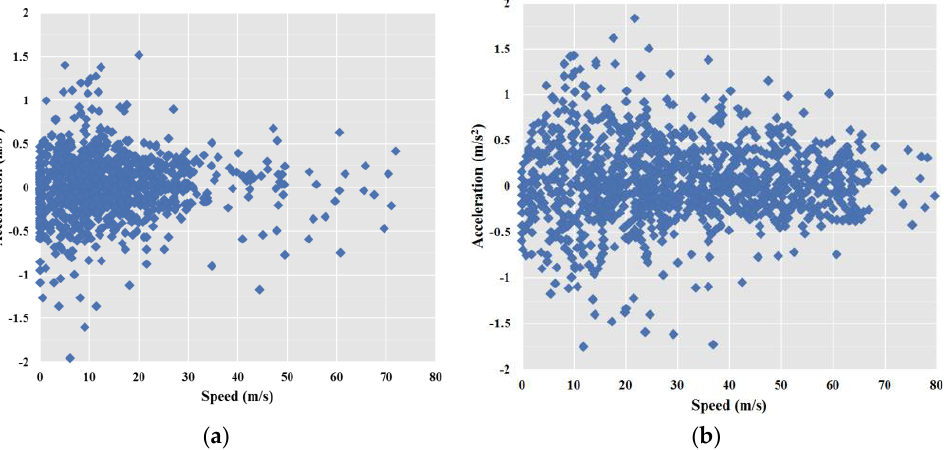
Figure 8. The typical distribution of speed acceleration driving condition points; ( a ) Peak hours (7:00 – 9:00, 17:00 – 19:00); ( b ) Off-peak hours (other time)